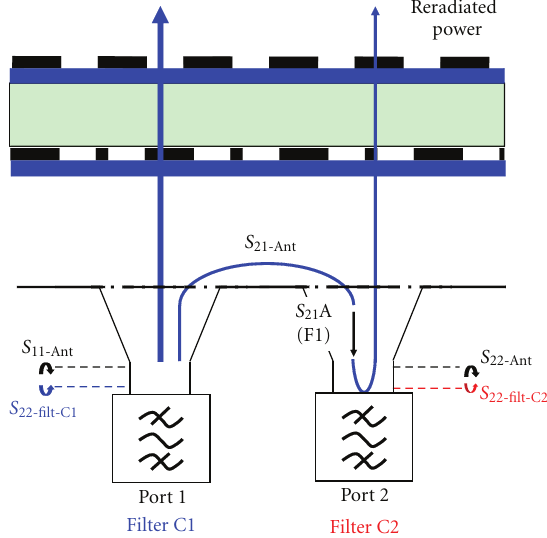
Figure 12: Multifeed EBG antenna loaded by